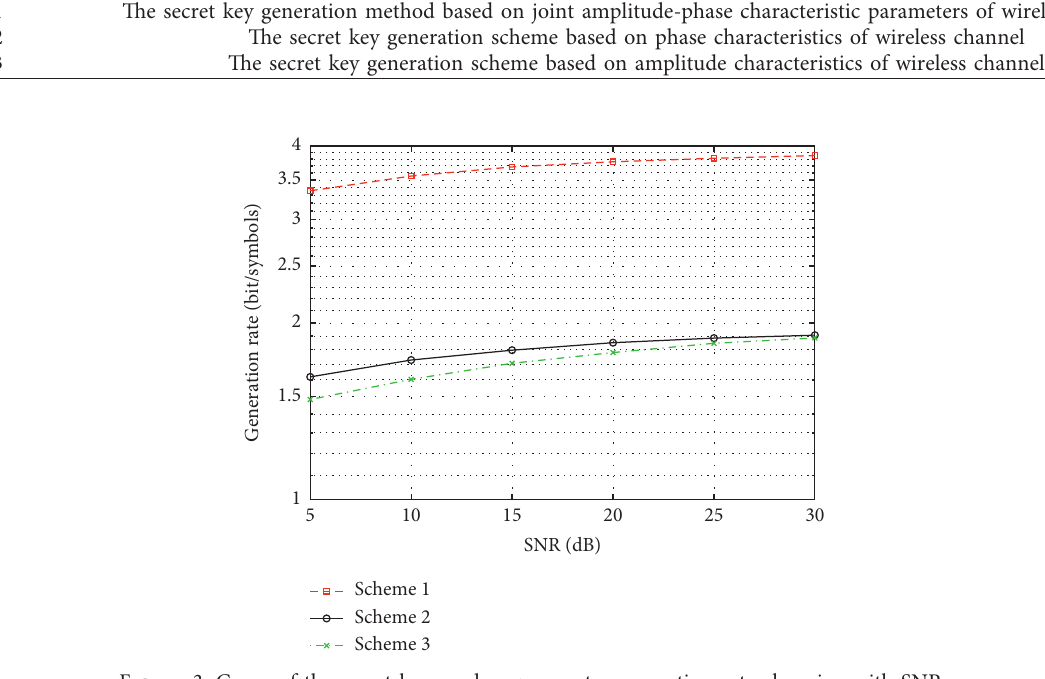
Figure 3: Curve of the secret key random parameter generation rate changing with SNR.